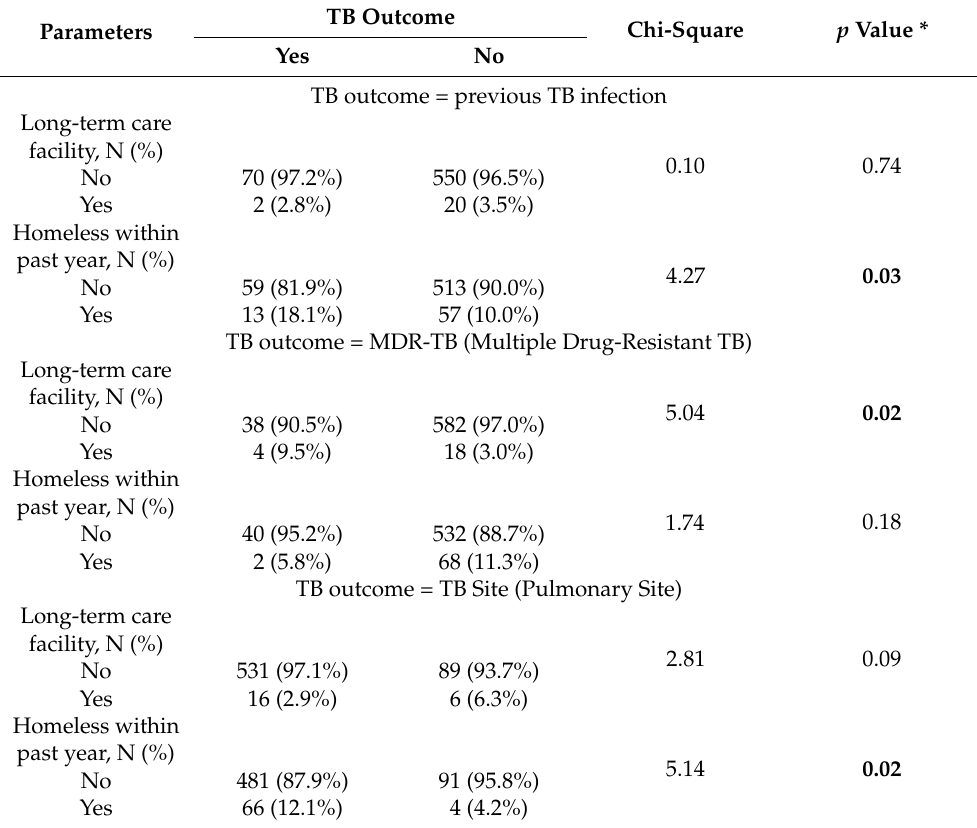
Table 5. Association between living in long-term care facilities and homelessness, and TB outcome among the TB cases in Mississippi. TB Outcome Chi-Square p Value Parameters